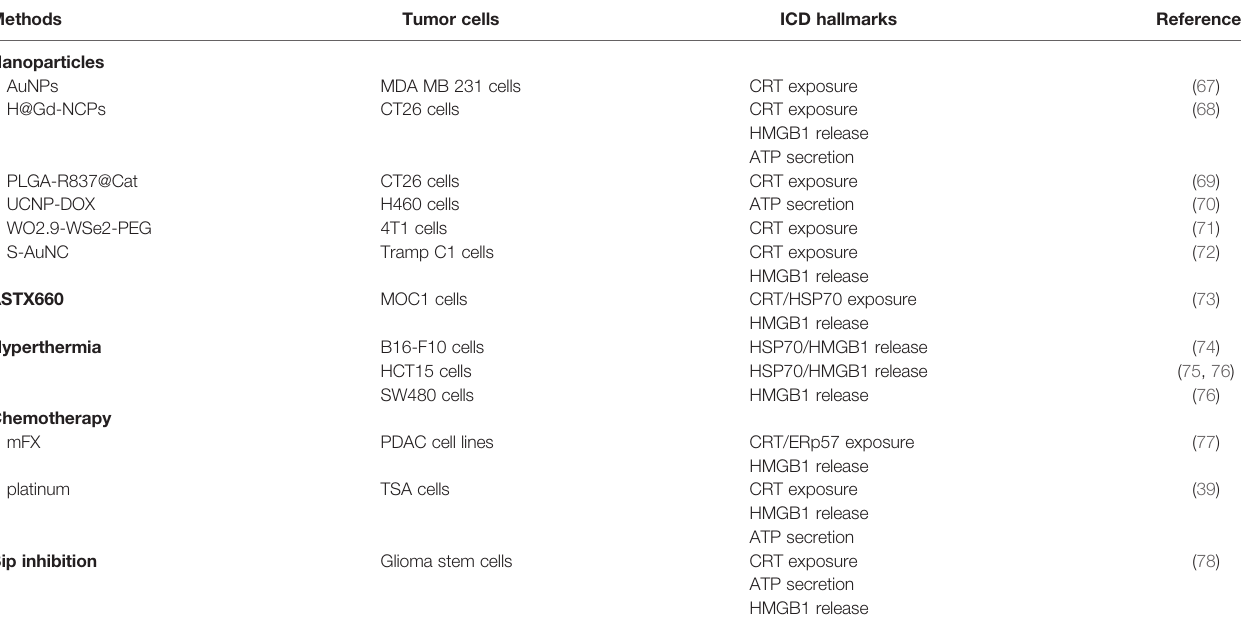
TABLE 1 | Methods promoting RT-induced